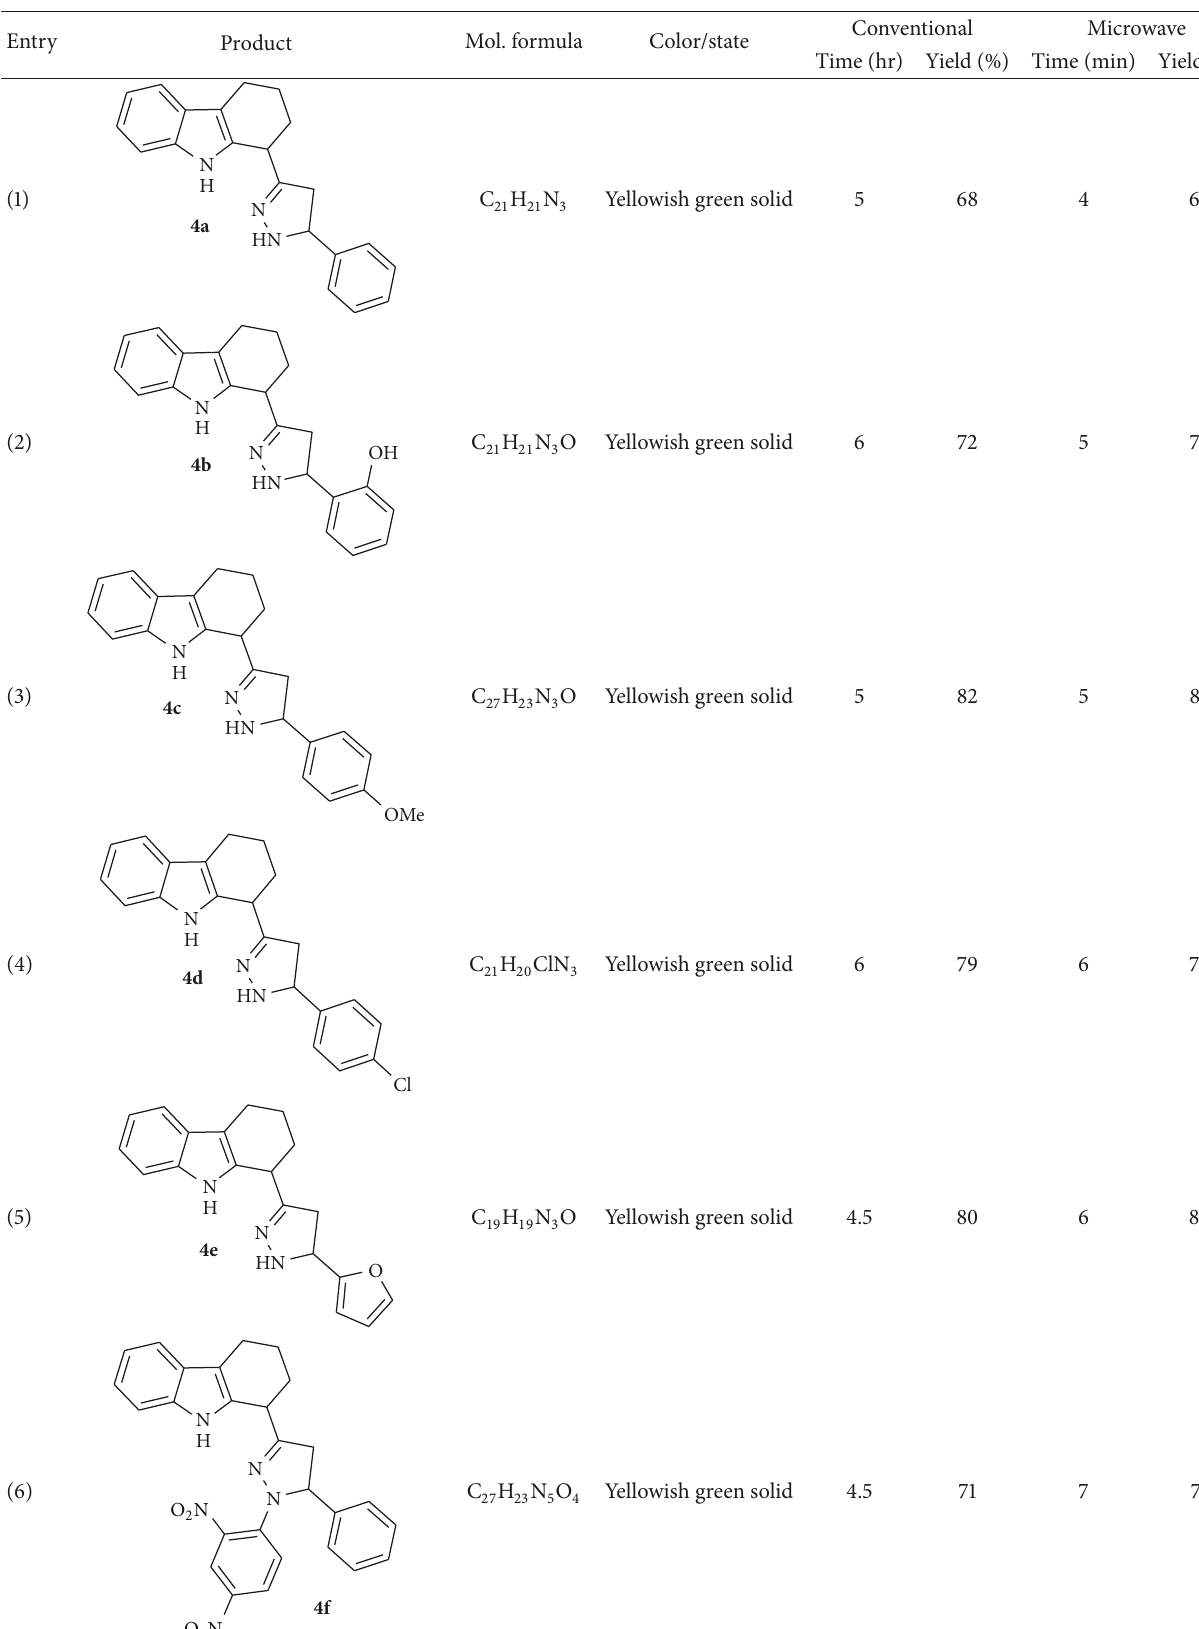
Table 2: Summary of physical data of synthetic diazoles